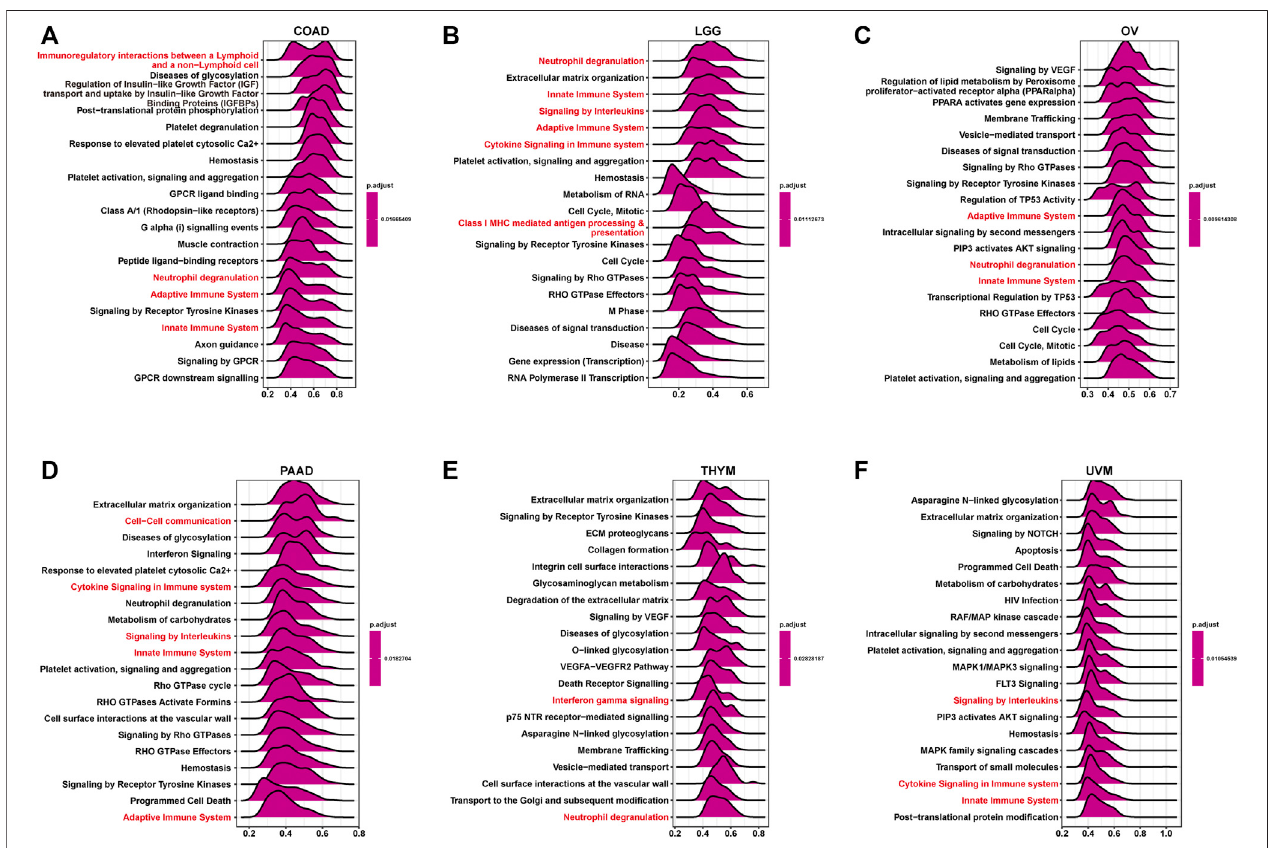
FIGURE5| GSEA ofTRPV4 inpan-cancer. (A – F) The top20GSEAresults inindicatedtumor types (NES ≥ 1.5,adjusted p -value < 0.05). Redindicates cellcycle- related or immune regulation-related